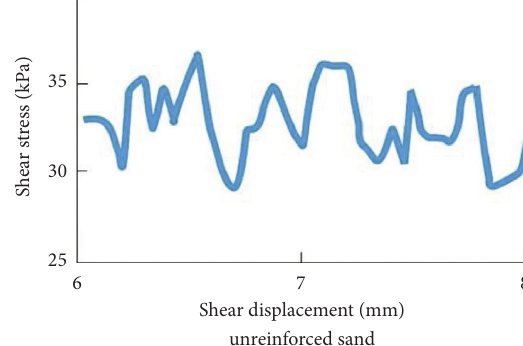
Figure 15: Vibration characteristics of shear stress in the 6–8 pfs region of shear displacement.